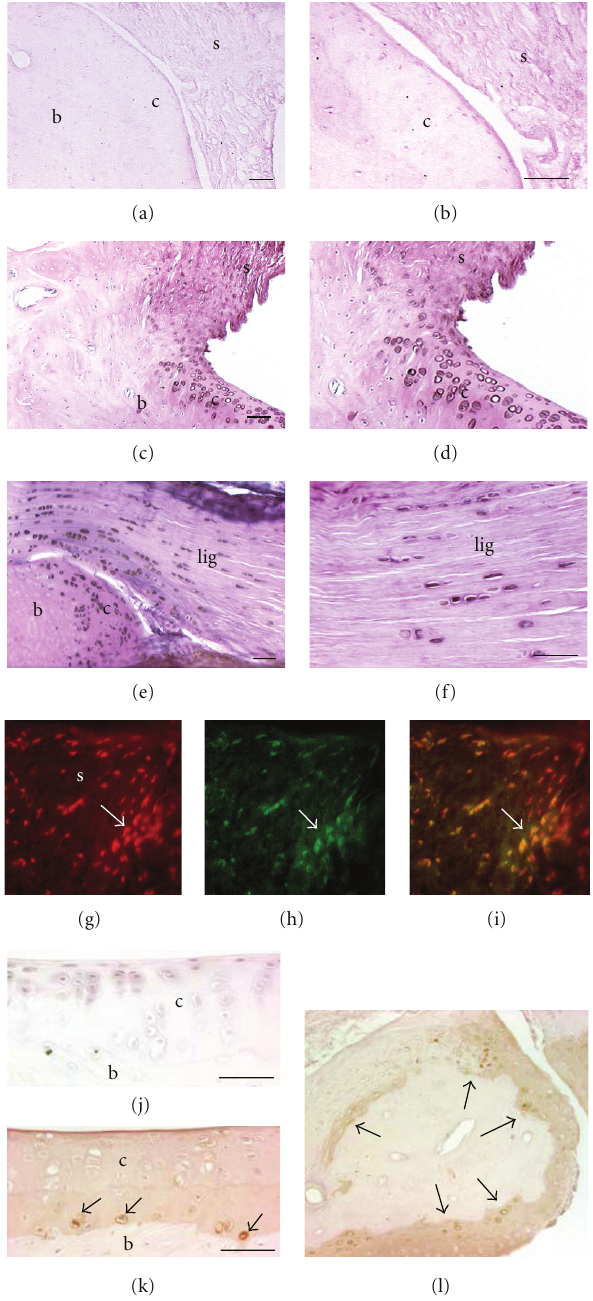
Figure 1: Immunohistological staining cyclooxygenase 2 (COX 2) and ED1 in HRHF distal radiocarpal articular cartilage, synovium and ligaments of longitudinally sections of para ffi n embedded bones. ED1 detects a 90 kDa lysosomal membrane glycoprotein in osteoclasts, phagocytic macrophages and their progenitors. (a)–(f) COX 2 staining was visualized using DAB intensified with cobalt (black signal); light hematoxylin and eosin ((h) and (e)) staining was used as a counterstain. (a) No COX 2 immunostaining was observed in distal radial articular cartilage and synovium of a normal control (NC). (b) Higher-power image of same section as shown in (a). (c) COX2+ cells are present in the articular cartilage and synovium of a 12-week high-repetition high-force (HRHF) rat’s distal radius. (d) Higher-power image of same section as shown in (c). (e) COX2+ cells are present in the distal radial articular cartilage and radiocarpal ligament of a 12 week HRHF rat. (f) Higher-power image of same section as shown in (e). (g)–(i) Several COX2+ cells are present in the radiocarpal synovium of an HRHF 12 rat (red cells). (g) Same section double labeled for ED1 (green cells, (h)). (i) Merged photo. Arrow indicates a group of COX2+/ED1+ double labeled cells. (j) ED1+ cells (brown DAB signal) were absent in distal radius articular cartilage of an NC rat. Section is lightly counterstained with hematoxylin. (k) Mononucleated ED1+ cells (arrows, presumably osteoclast progenitor cells) were observed in the subchondral bone of the distal radius of an HRHF rat. (l) ED1+ cells were also present in HRHF carpal bones. Scale bars = 50 μ m. b: bone, c: articular cartilage, lig: ligament, s: